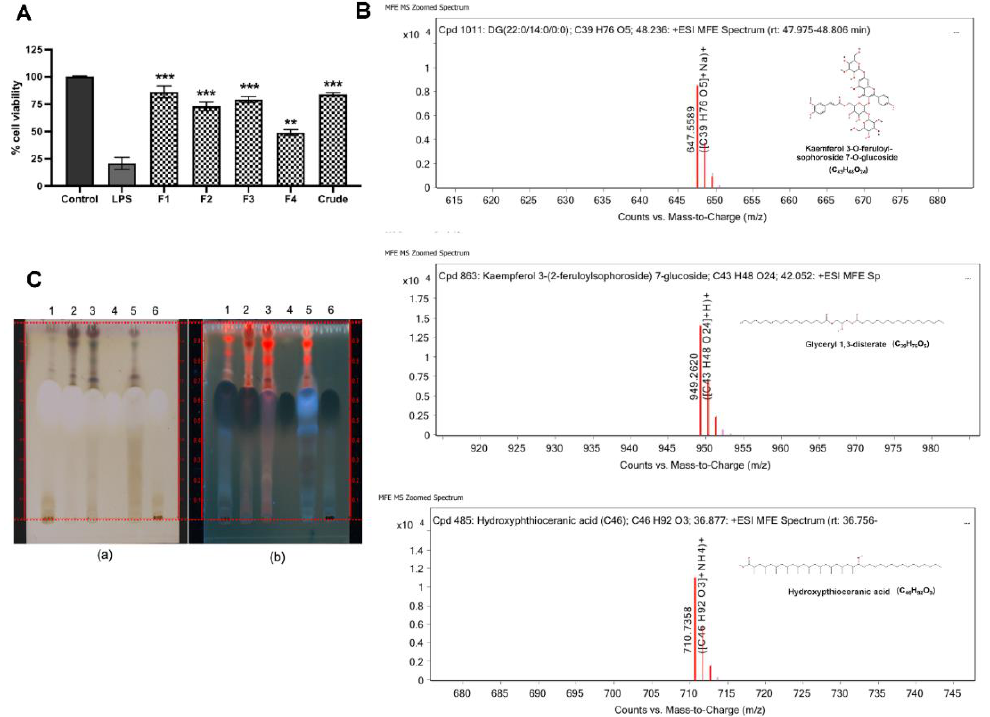
Figure 4. Characterisation of bioactive compounds in C. nutans extract. ( A ) The biological activities of four fractions—hexane fraction (F1), dichloromethane fraction (F2), ethyl acetate fraction (F3), and water fraction (F4), respectively—derived from sequential fractionation to reduce LPS-induced cell death were tested using Prestoblue ™ reagent (* indicates p < 0.05, ** indicates p < 0.01, and *** indicates p < 0.001). ( B ) The mass spectra and molecular structure of three overlapped majorcompounds—glyceryl 1,3-disterate (C 39 H 76 O 5 ), m / z 647.5589, exact mass 624.5681 (B1); kaempferol 3-O-feruloyl-sophoroside